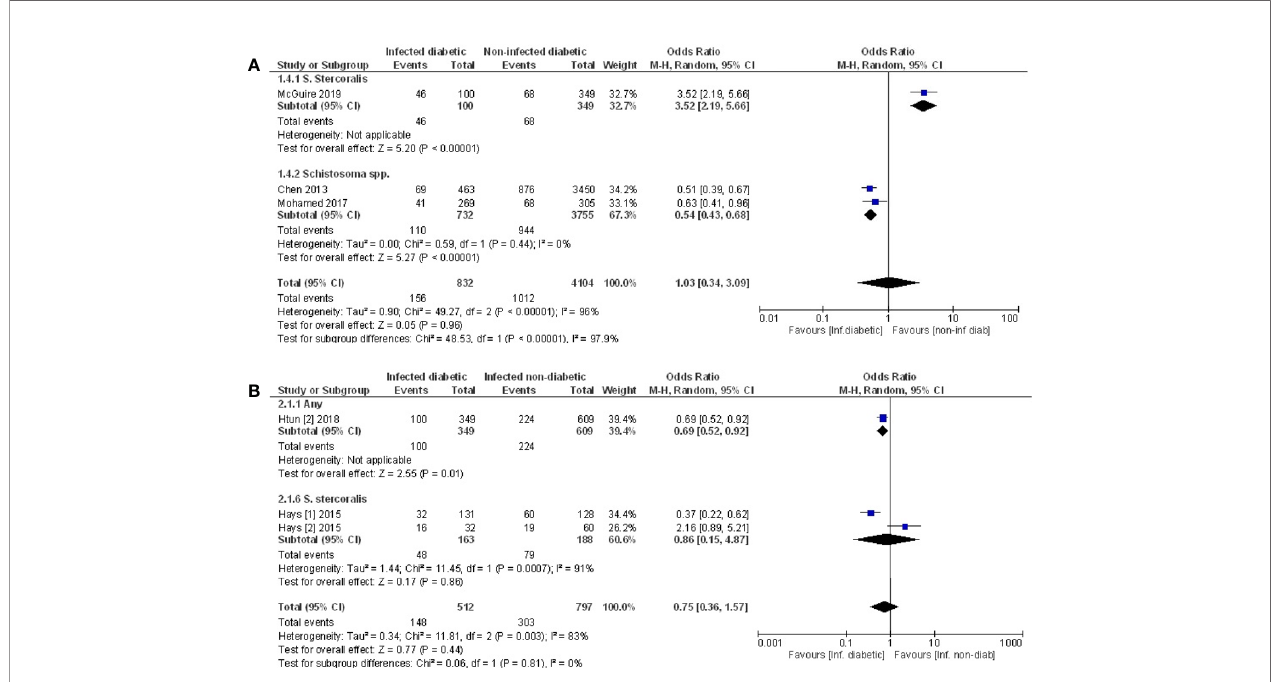
FIGURE 5 | Prevalence of type 2 diabetes in infected or non-infected individuals. (A) Forest plot of studies illustrating that prevalence of T2D is not affected by infection when all studies are pooled. Subgroup analysis of only Schistosoma infection shows infection is associated with lower prevalence of T2D. (B) Forest plot of an infected population with diabetes vs. an infected population without diabetes shows people are less likely to develop diabetes if